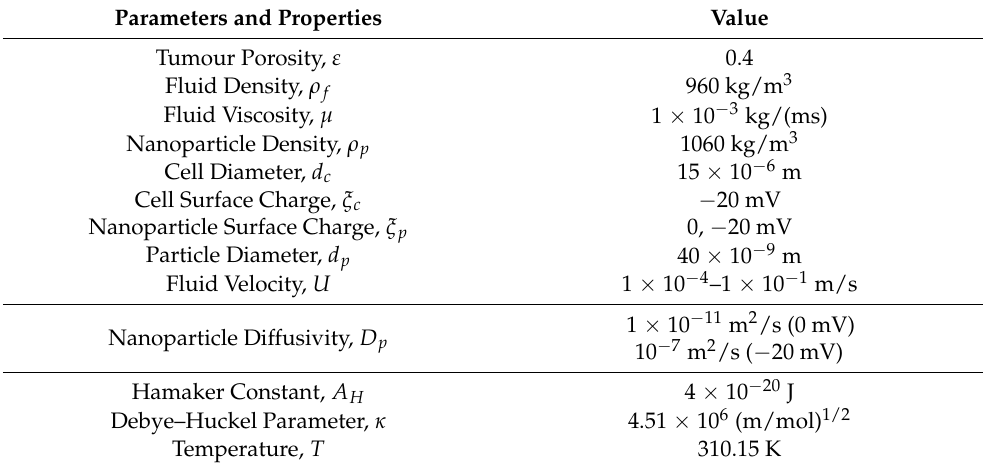
Table 3. Properties and parameters for the correlation equations (Data extracted from